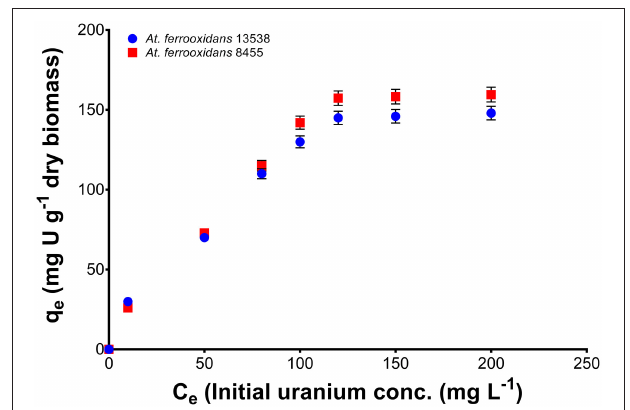
FIGURE 6 | Sorption isotherms for At. ferrooxidans strains 8455 and 13538 obtained at pH 3.5. The data fitted a Langmuir equation. Error bars correspond to 1 standard deviation of the